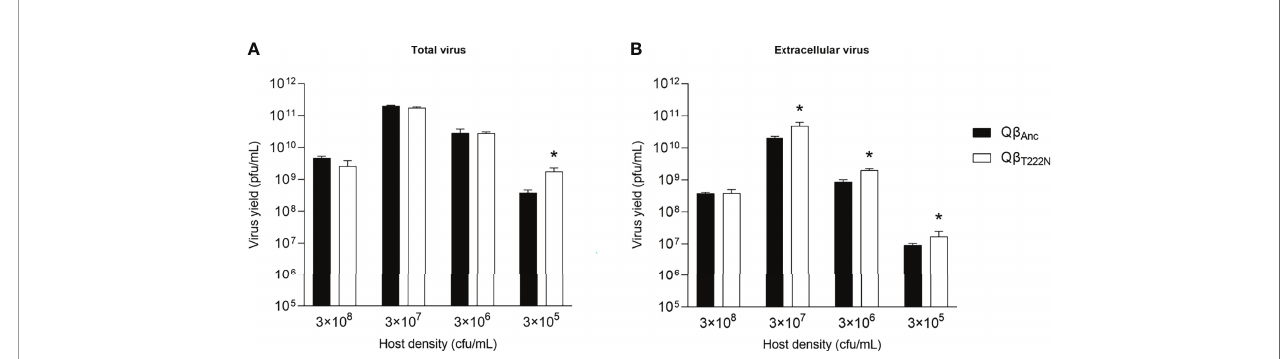
FIGURE 4 | Replicative ability of the viruses Q b Anc and Q b T222N . Each bar represents the average of three replicas for either Q b Anc (black) or Q b T222N (white). Both viruses were assayed at the bacteria density indicated at the bottom of the fi gure. (A) Total virus. (B) Extracellular virus. Asterisks above the bars indicate that the result is signi fi cantly different from the value obtained for the virus Q b Anc ( p < 0.05) according to a Mann Whitney test. The absence of asterisk indicates that the value obtained did not signi fi cantly differ from that of